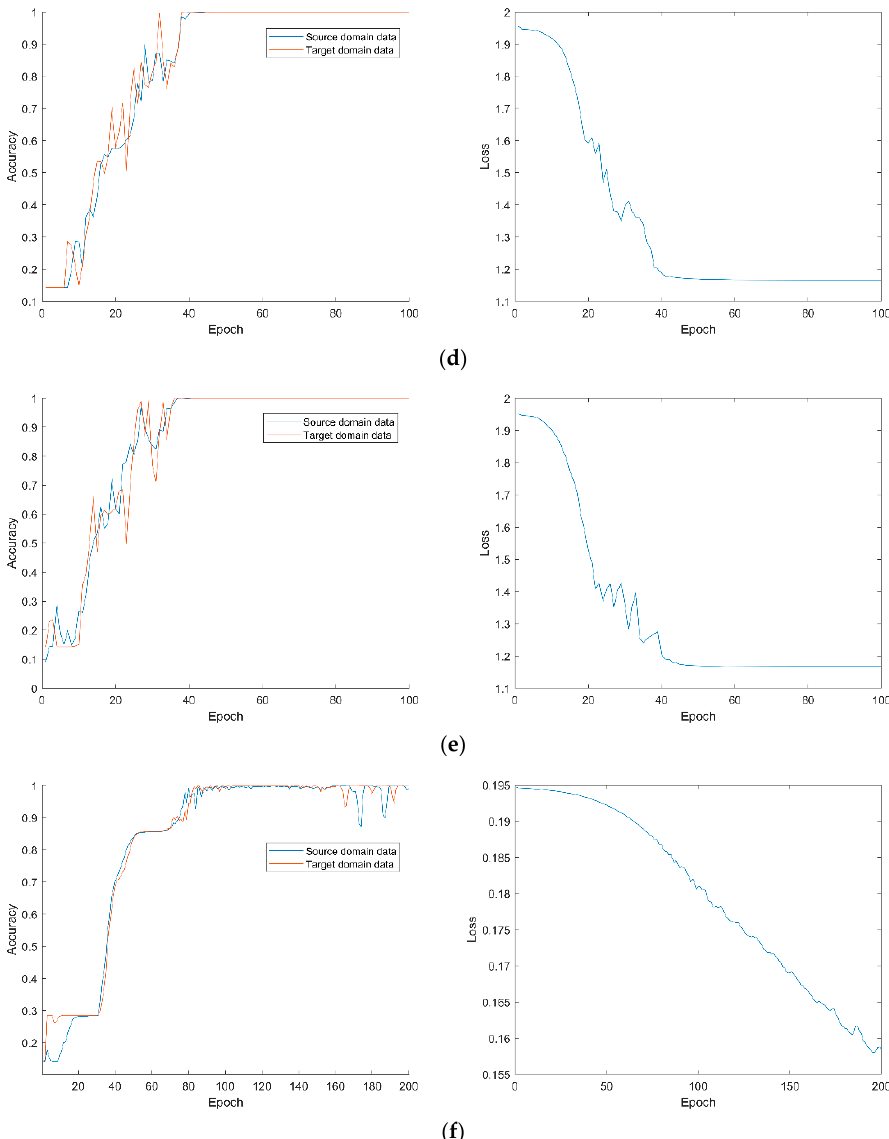
Figure 17. Network training and loss function curves under different transfer tasks: ( a )transfer task A → B ; ( b ) transfer task A → C ; ( c ) transfer task A → D ; ( d ) transfer task B → C ; ( e ) transfer task B → D ; ( f ) transfer task C → D